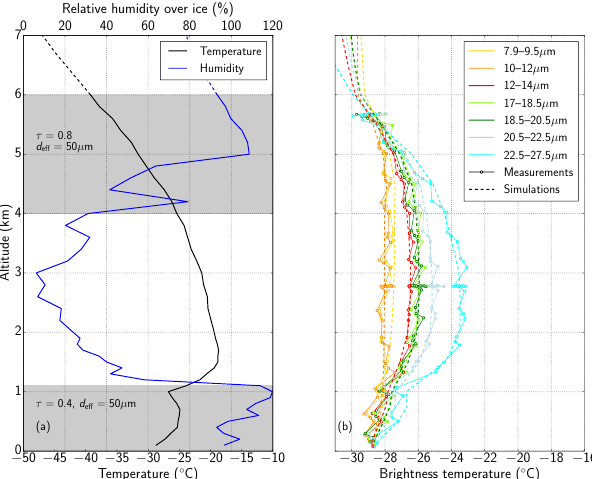
Figure 11. Vertical profiles of (a) temperature and relative humid- ity and (b) measured and simulated FIRR brightness temperatures for 7 April flight. Shaded areas in panel (a) indicate the presence of clouds. The optical thickness and particle effective diameter used for the simulations are also indicated. The dashed lines correspond to the ERA-Interim profiles used for the simulations above maxi- mum flying